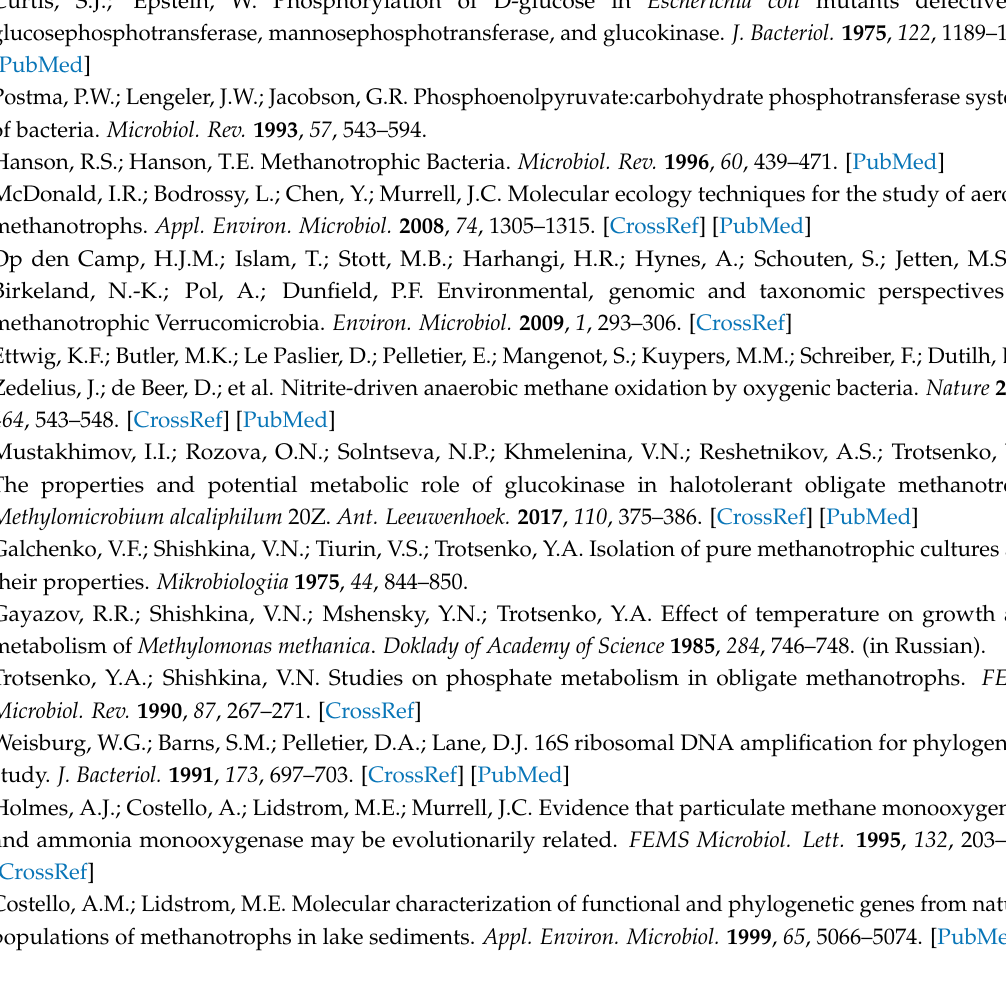
Figure S1: The phylogenetic position of Methylomonas strain 12 among methanotrophs of the Gammaproteobacteria class and the genus Methylomonas . The methanotroph of the class Alphaproteobacteria , Methylocystis parvus , was used as an outgroup. Accession numbers are given in parentheses. Bar, 0.02 substitutions per nucleotide position; Figure S2: Phylogenetic analysis of the derived PmoA sequence from Methylomonas sp. 12. Bar, 0.02 substitutions per nucleotide position. The methanotroph of the class Alphaproteobacteria , Methylocystis parvus , was used as an outgroup; Figure S3: Effect of ATP on activity of polyP-Glk from Methylomonas sp. 12. PolyP Glk does not use ATP as a substrate in the absence of